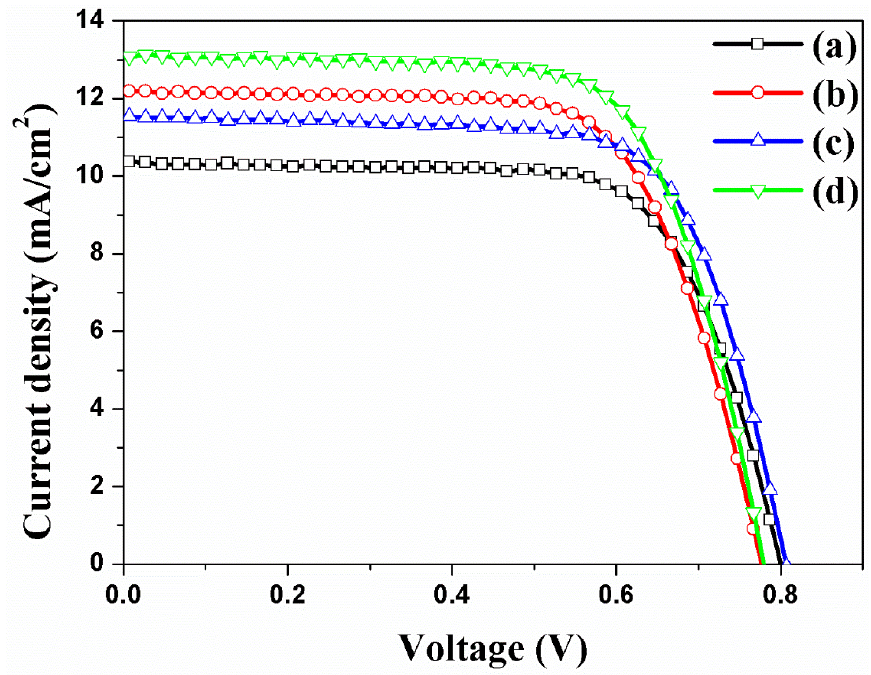
Figure 6. I–V curves of DSSCs based on the f-TNTAs: (a) without both Au NPs and a scattering layer, (b) with Au NPs, (c) with a scattering layer, and (d) with Au NPs and a scattering layer. Table 2. Photovoltaic properties of DSSCs based on f-TNTAs with Au NPs and a scattering layer. DSSCs Based on the f-TNTAs